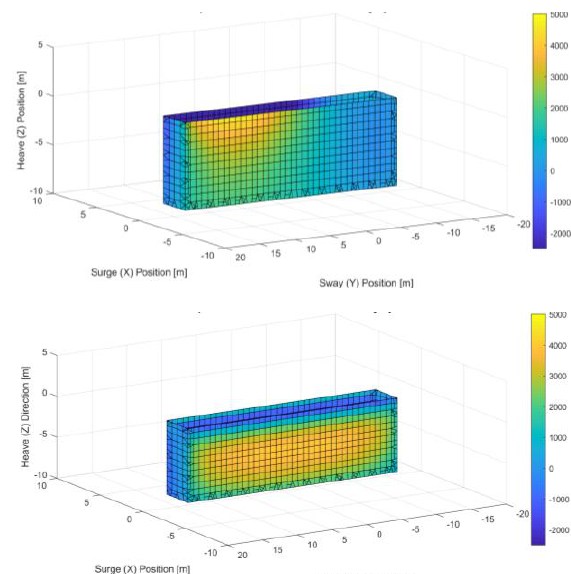
Fig. 3. Examples of the derived distributed diffraction (top) and added-mass (bottom)